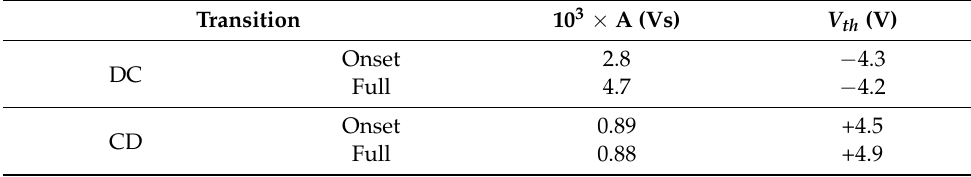
Table 1. Fitting parameters for Figure